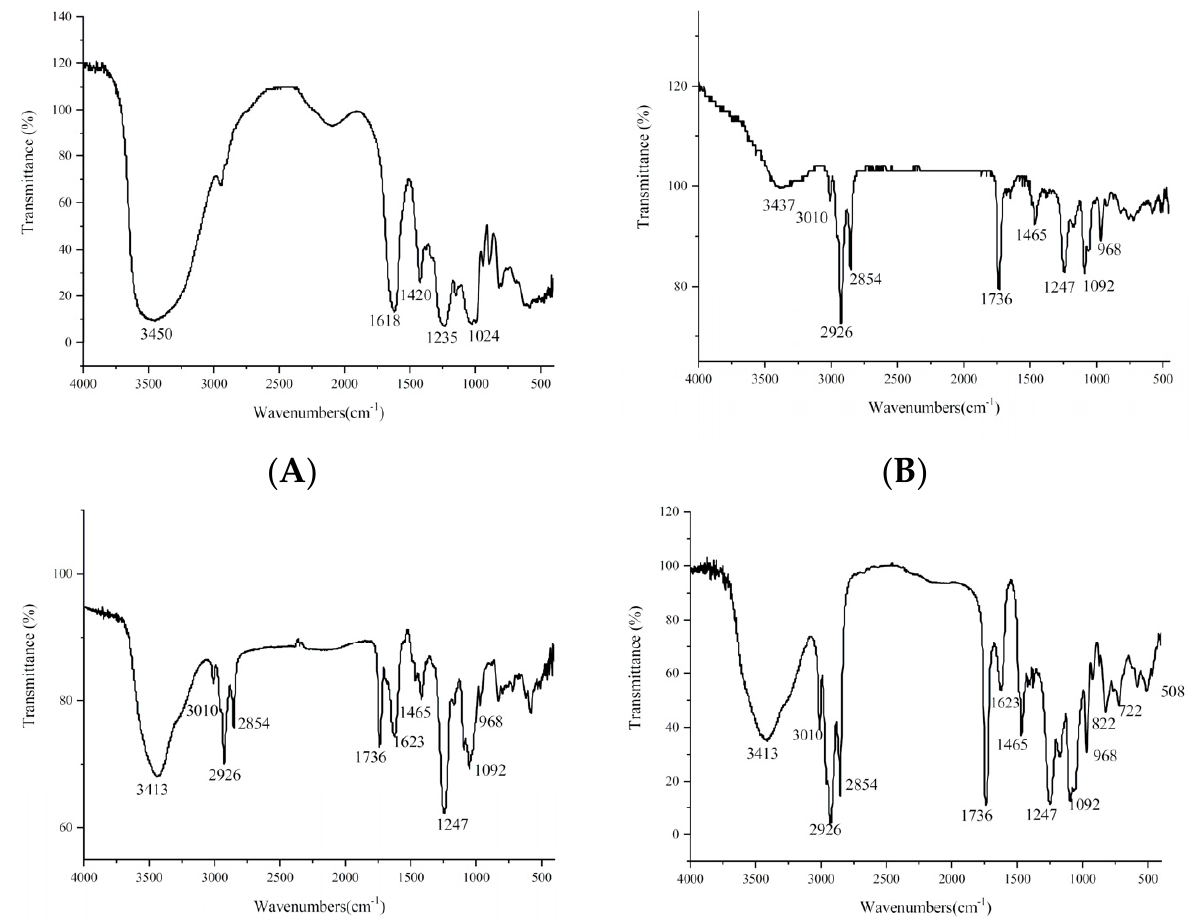
Figure 2. Fourier-transform infrared (FT-IR) spectra of ( A ) heparin, ( B ) phospholipids, ( C ) physical mixture of heparin and phospholipids, and ( D ) HEP–Pc complex.